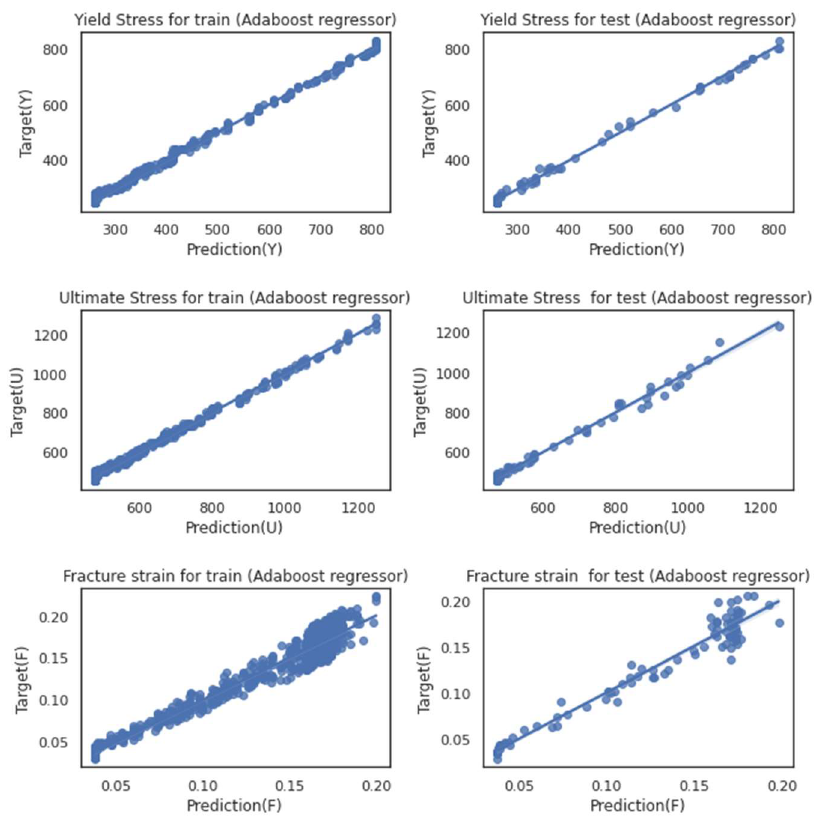
Figure 10. Dataset parity plot while using the Adaboost regressor for training (right figures) and testing (left figures) datasets for three mechanical properties: yield stress (Y), ultimate stress (U), fracture strain (F).